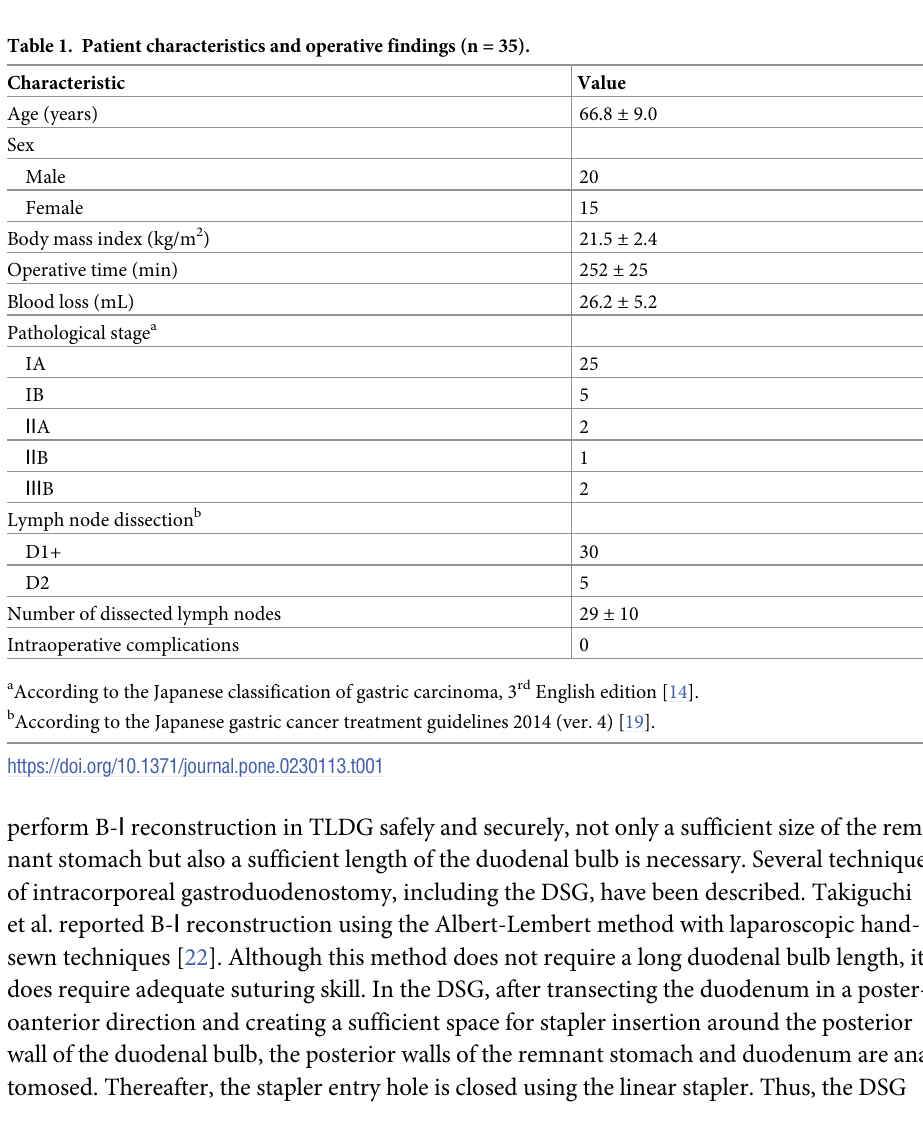
Table 1. Patient characteristics and operative findings (n = 35).